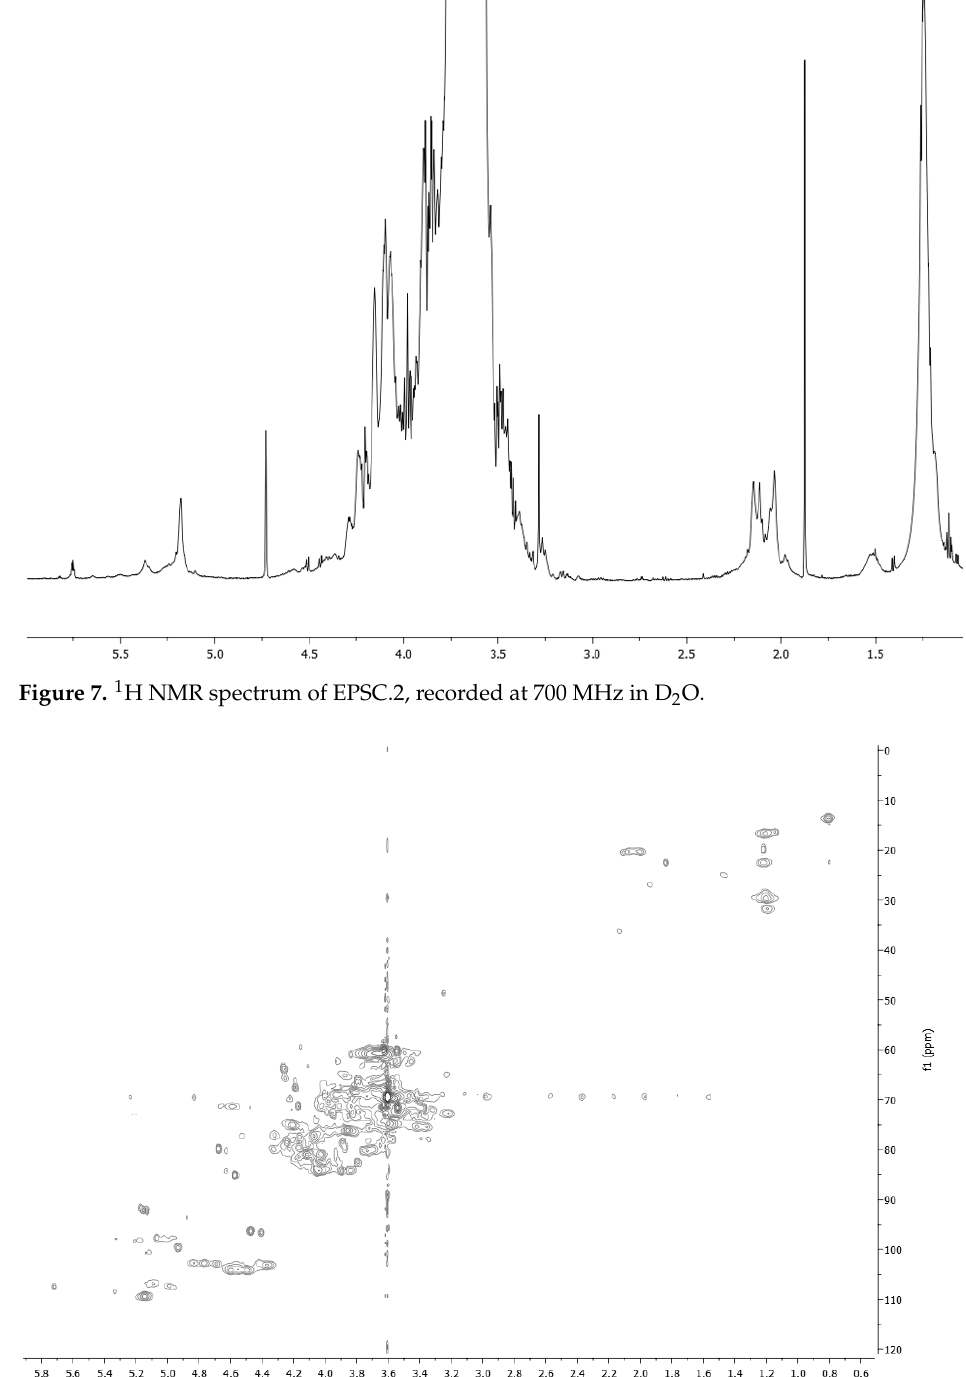
Figure 8. 2D HSQC NMR spectrum of EPSC.2, recorded at 700 MHz in 2 H 2 O.